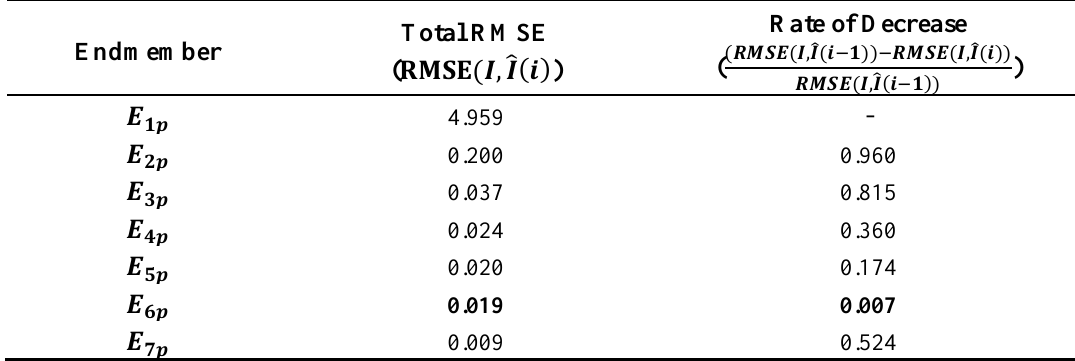
Figure 8. The spectra of the endmember set for the AISA data. ( a ) After the first step; ( b ) After the final step. Table 3. RMSEs and rates of change of extracted endmembers. The values shown in bold italics are those of endmembers for which the rate of decrease is less than 0.1.